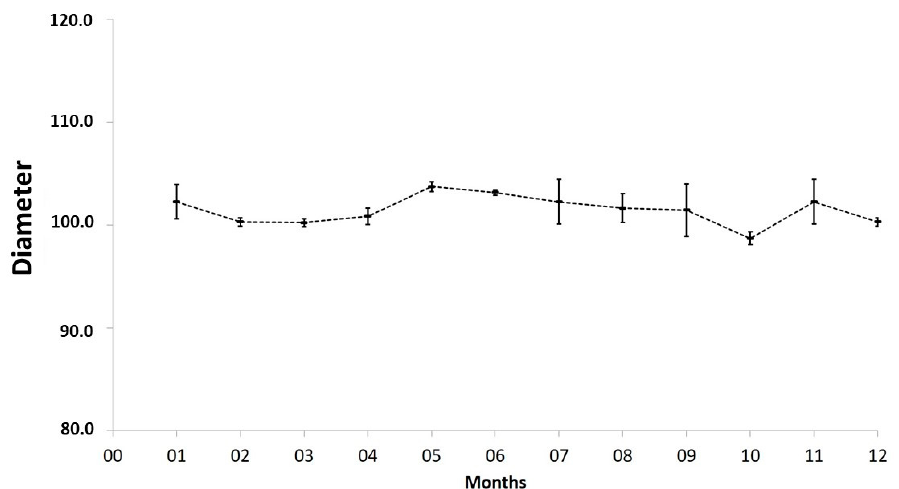
Figure 6. Average size of the nanoxylan particles evaluated over a 12-month period.